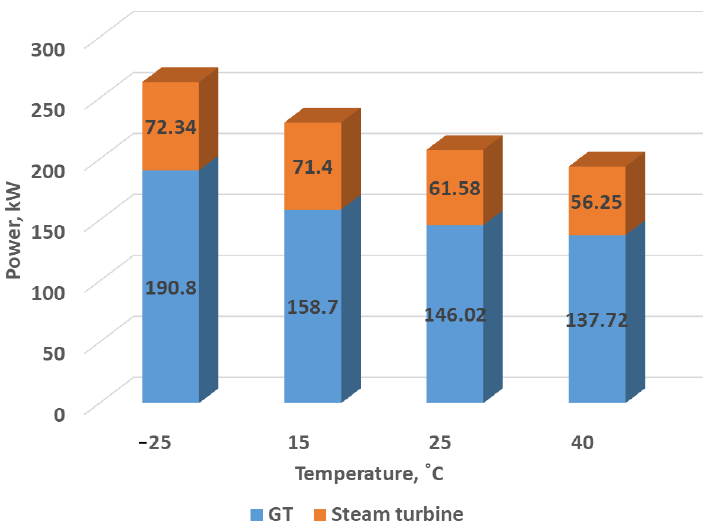
Figure 7. Dependence of power generation on ambient temperature of CCPP.